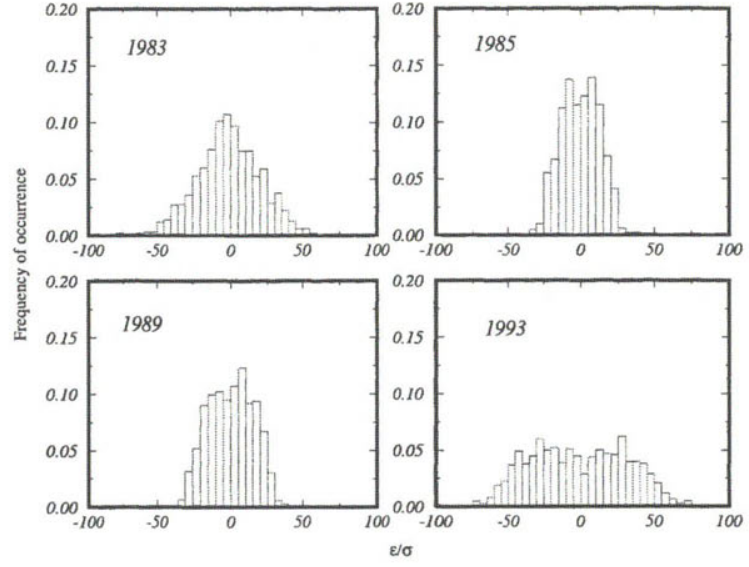
Fig. 4. Distributions of the values of e/σ of error/sigma tests for the values of σψ calculated from LSINF for four different data sets (number of simulations =